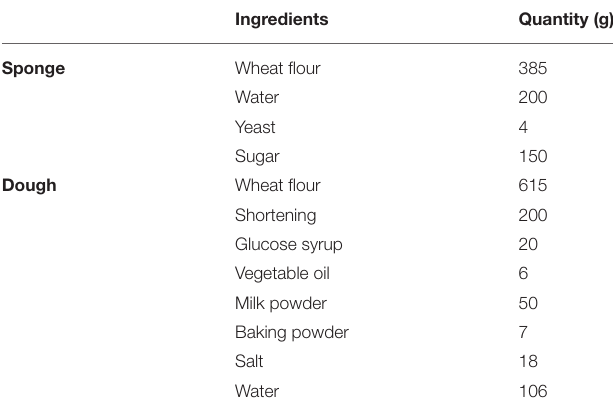
TABLE 1 | Basic cracker formula, modified from Maisont and Khucharoenpaisan (37).